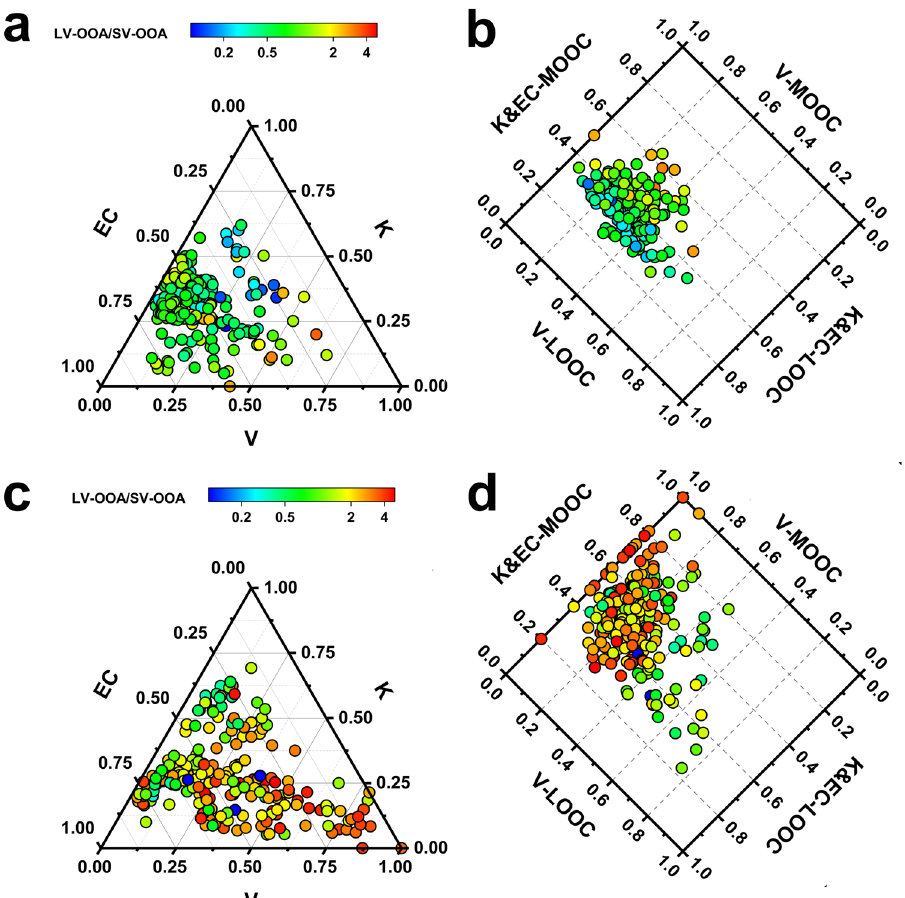
Fig. 4 The mixing state of OOA during two periods. Ternary plots for the EC, K, and V particles during a the LDP and c MDP. The EC, K, and V particles are normalized such that these three components comprise a total of 100%; the fractions of the LOOC and MOOC particles in the EC, K, and V particles during b the LDP and d